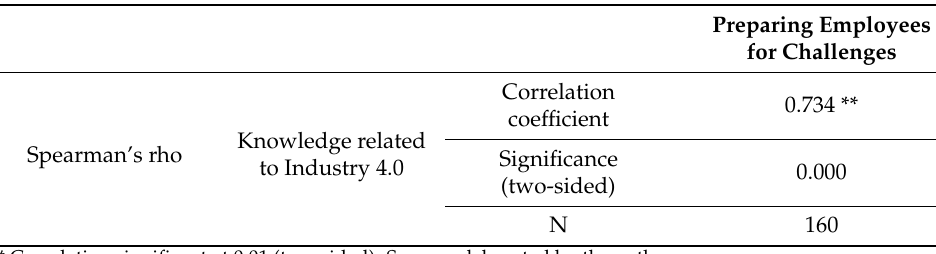
Table 2. Correlation Between the Employees’ Knowledge Regarding the Industry 4.0 Concept and Preparing Them for Challenges—Results for Poland and